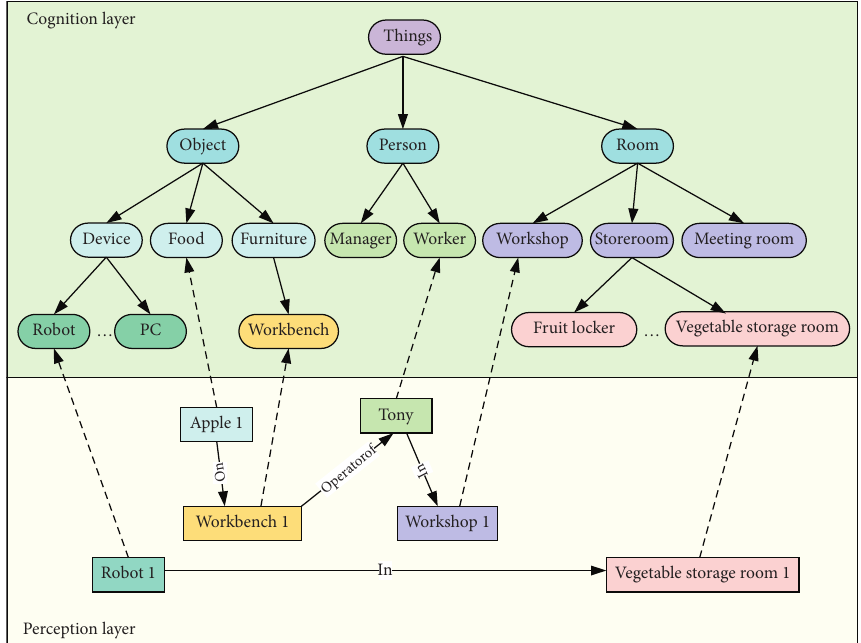
Figure 5: Schematic diagram of the cognition layer and perception layer in knowledge base.